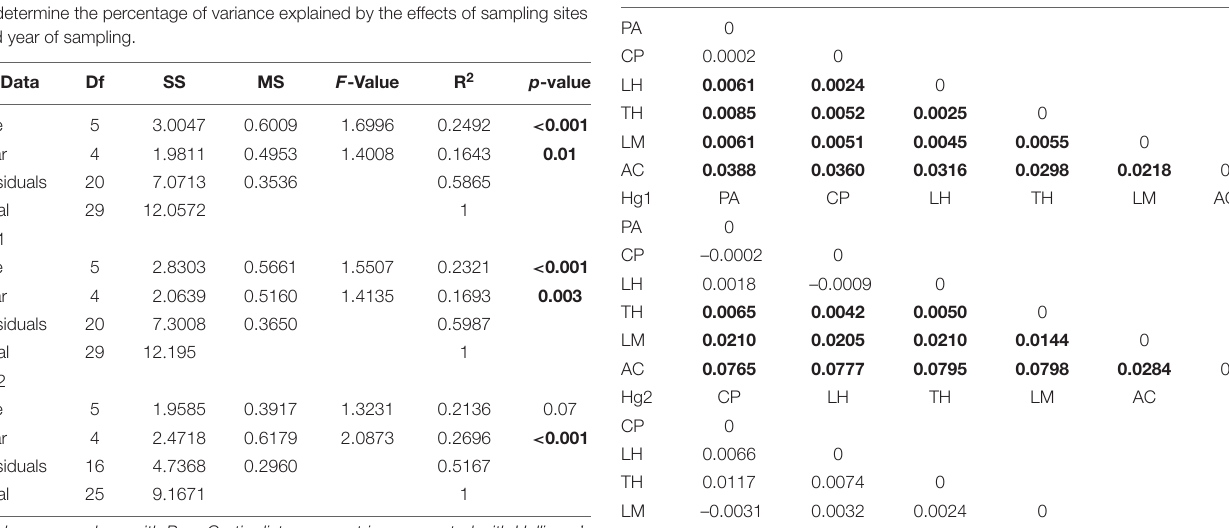
Analyses were done with Bray-Curtis distances matrices corrected with Hellinger’s method using haplotype frequencies. Df, degrees of freedom; SS, sum of squares; MS, mean squares. Significance (in bold) assessed after 10,000